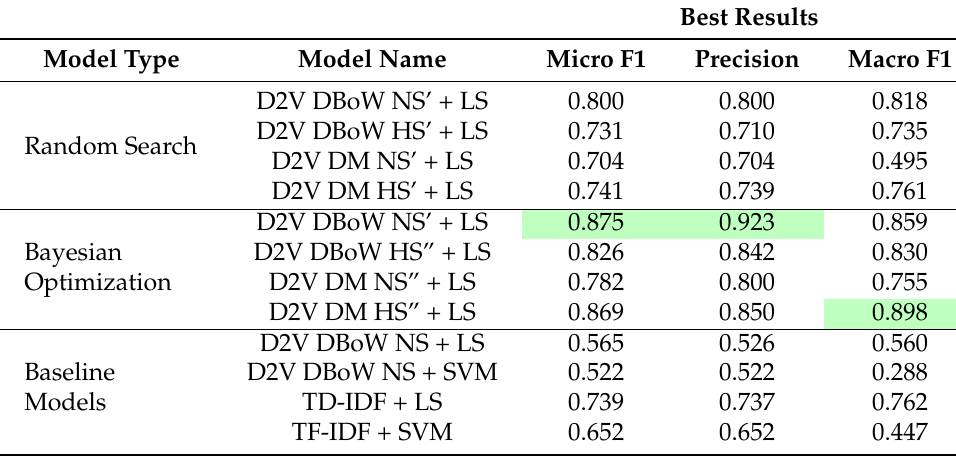
Table 8. Best predictions from the Unsafe act